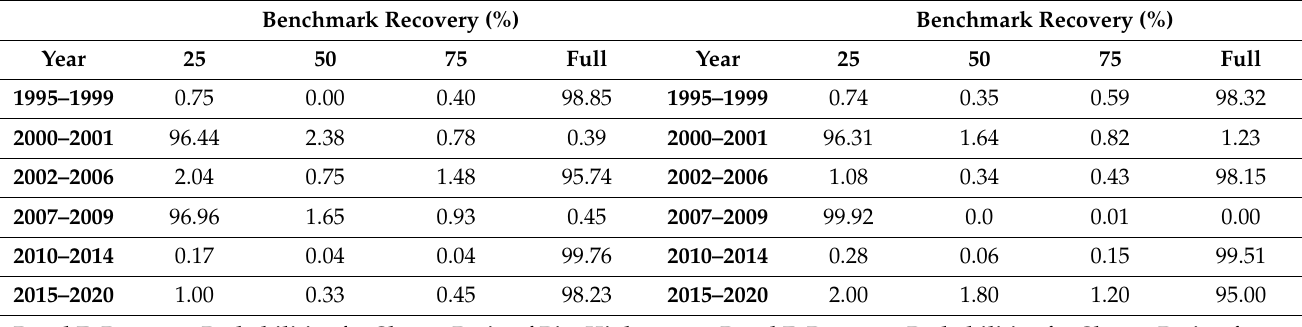
Panel E: Recovery Probabilities for Sharpe Ratio of Big–High Operating Profit Stocks